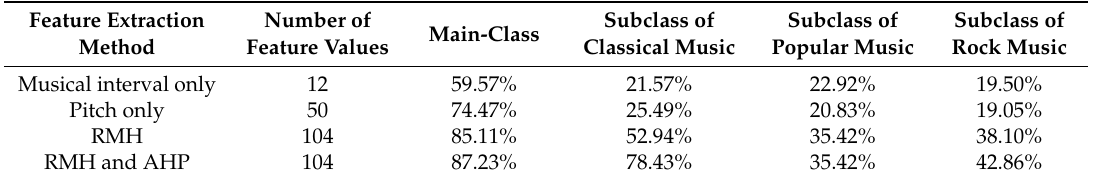
Table 5. Comparison of classification accuracy of different feature extraction methods. RMH: rhythm, melody, and harmony; AHP: analytic hierarchy process.